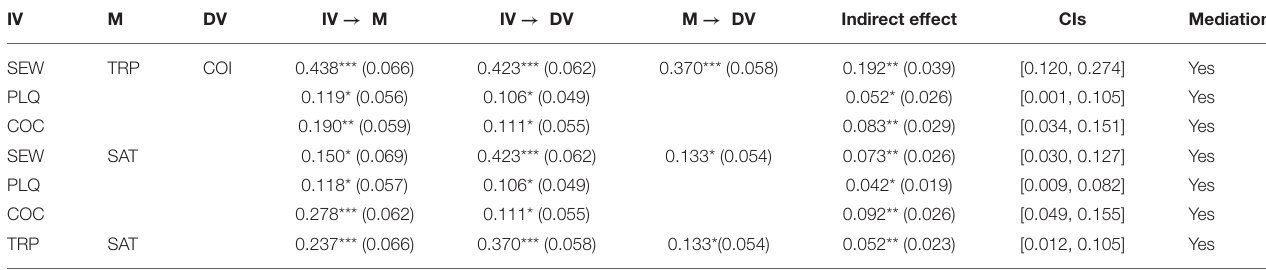
TABLE 6 | Results of mediating effect